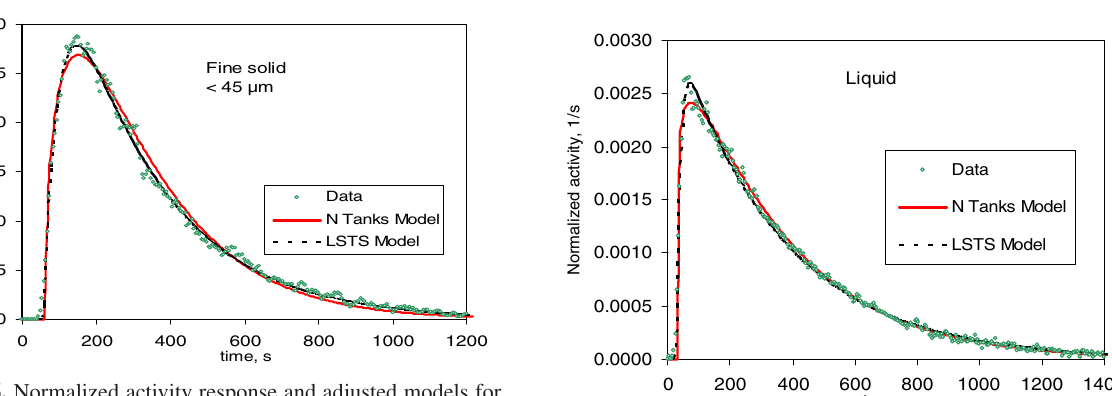
Figure 6. Normalized activity response and adjusted models for fine solid tracer in cell tailings.